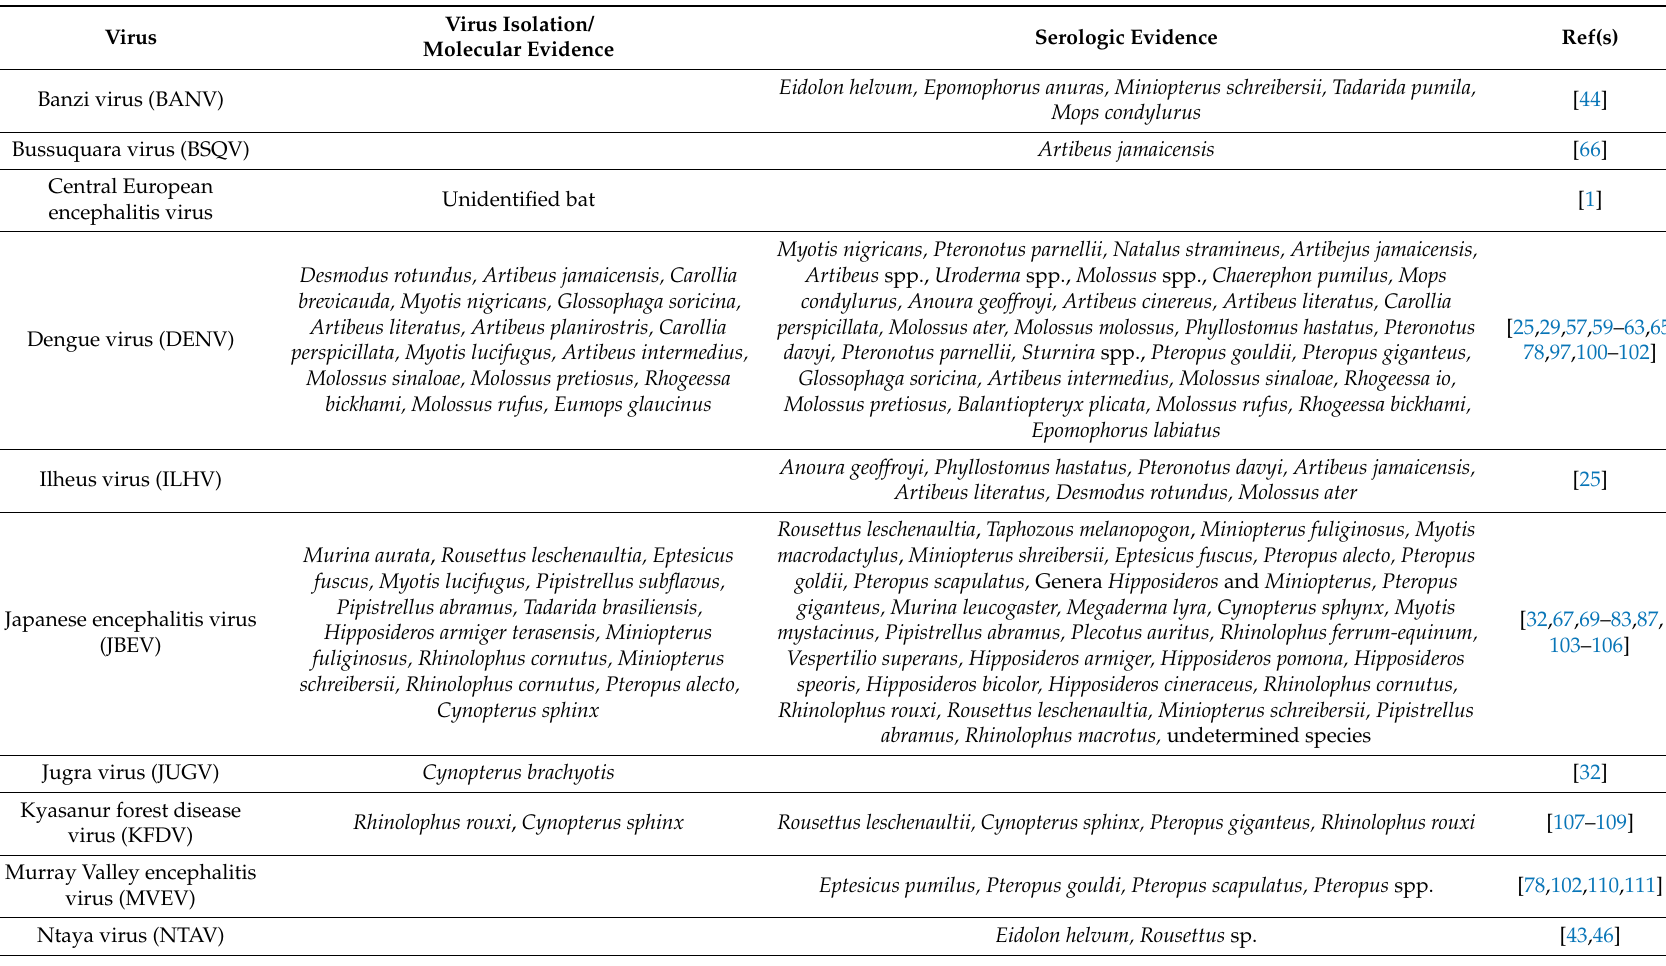
Table 2. Table describing species with published results describing virus isolation, molecular evidence, or seroconversion to species in genus Flavivirus (family Flaviviridae